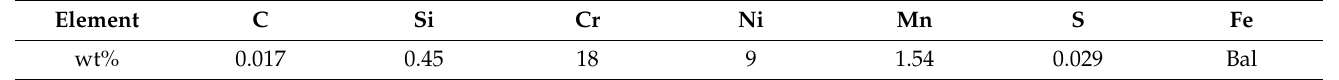
Table 1. The compositions of the base metal of the 304L stainless steel plates (wt%).